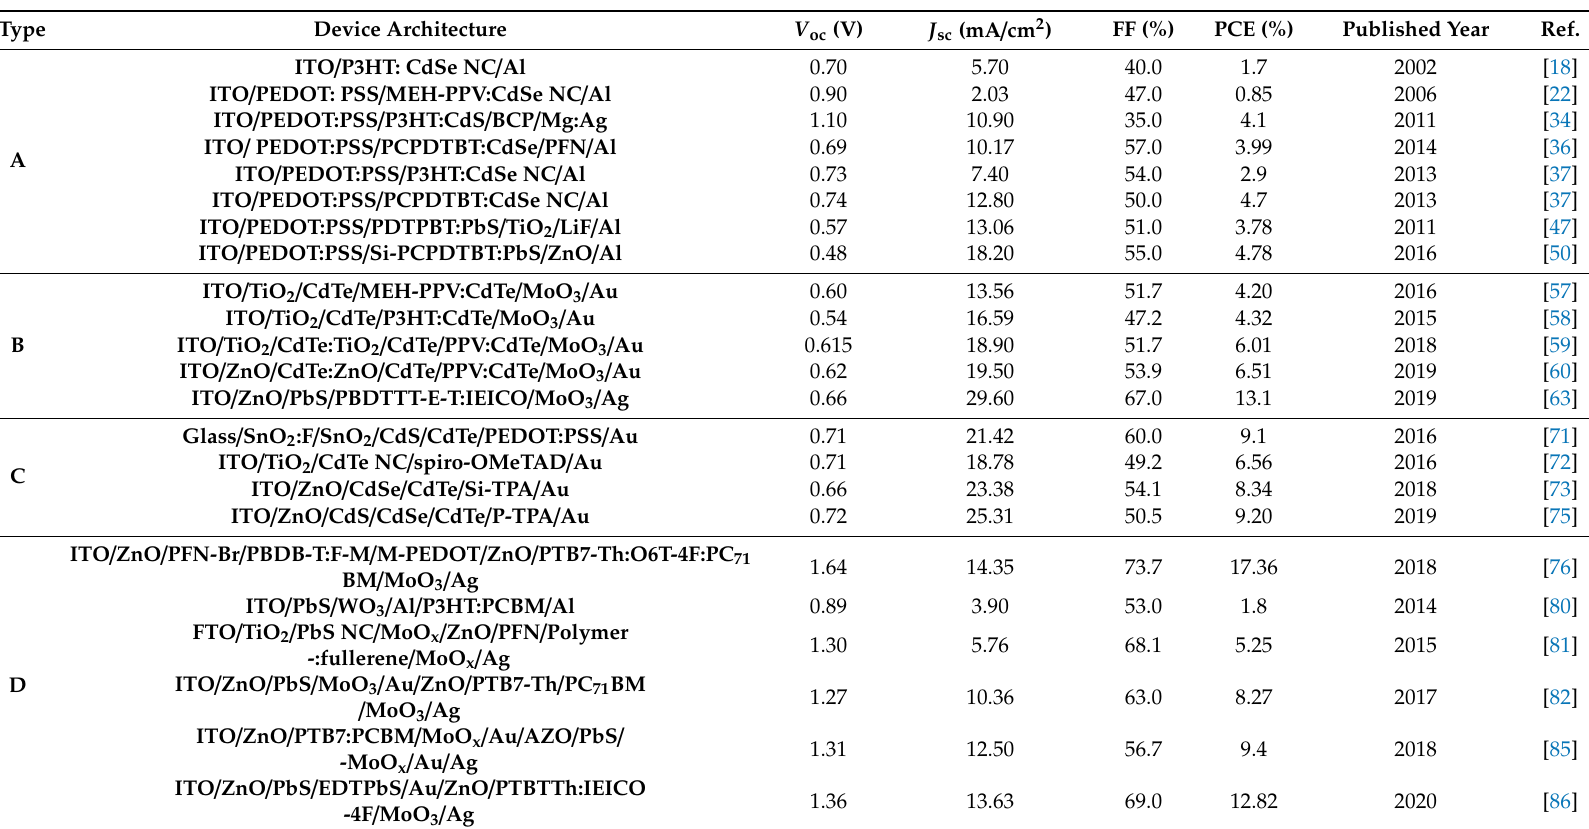
Table 1. HSC solar cell devices with all kinds of device configurations. Device type: ( A ) Hybrid bulk heterojunction solar cells with semiconductor NCs as acceptors. ( B ) Hybrid solar cells with more active layers. ( C ) Hybrid solar cells using organic materials as hole transfer layers. ( D ) Hybrid solar cells with tandem structures.